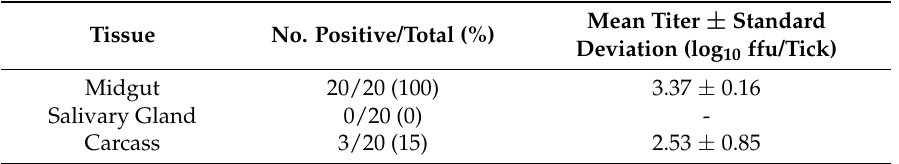
Table 3. Comparative Langat virus titers from selected organs of unfed adult Haemaphysalis longicornis at 28 days post infection (dpi).